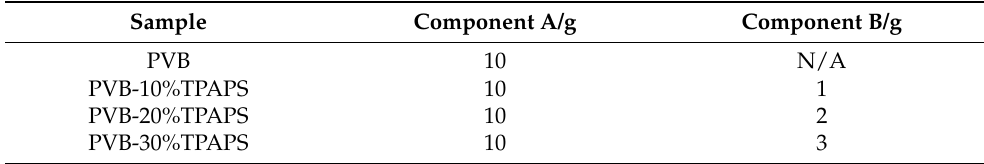
Table 1. The composition formulas of different